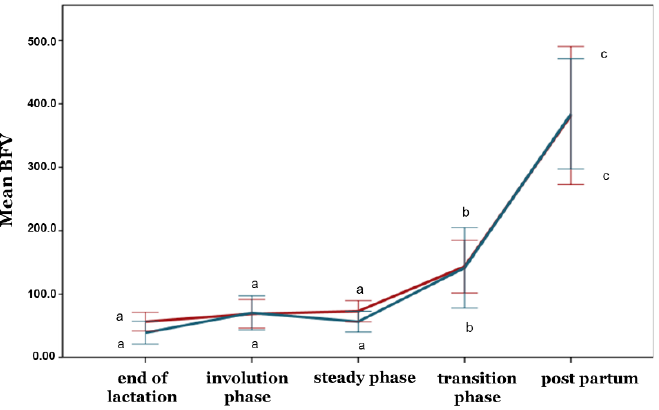
Figure 9. Blood flow volume changes among the periods and between the ewe groups ( p ≤ 0.05). The different letter indicators (a, b, c) represent statistically significant differences between the periods. The green line represents the ewe group with healthy udders, while the red represents the ewe group with subclinical mastitis.